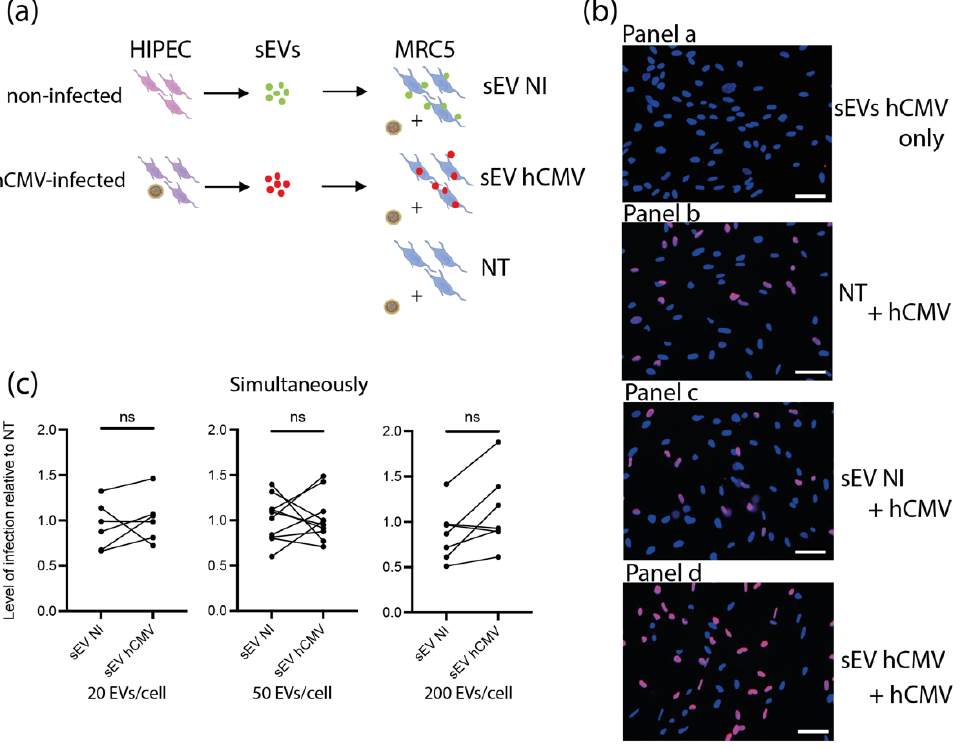
Figure 4. Effect of HIPEC sEVs on MRC5 cell permissiveness for hCMV. ( a ) Experimental procedure (NT = non-treated). ( b ) Immunofluorescence performed on MRC5 cells against IE viral antigen (blue: DAPI; red: IE1/2). Panel a- Non-infected control MRC5 cells upon 24 h incubation with sEVs isolated from hCMV-infected HIPECs. Panels b,c,d- MRC5 cells were either non-treated (Panel b- NT) or incubated during 2 h with sEVs prepared from non-infected (Panel c- sEV NI) or infected HIPECs (Panel d- sEV hCMV) with 50 sEV per cell, then infected during 24 h with hCMV at a MOI of 0.5 before proceeding to immunofluorescence. Scale bar: 200 μ m. ( c , d ) MRC5 cells were incubated with sEVs prepared from non-infected (sEV NI) or hCMV-infected (sEV hCMV) HIPECs and infected by hCMV at a MOI of 0.5, concomitantly ( c ) or 2 h after sEV incubation ( d ). Three increasing doses of sEVs were used in these experiments (20, 50, or 200 sEV per MRC5 cell, from left to right). Then, 24 h later, expression of IE antigen was assessed by immunofluorescence. Quantification of the percentage of IE positive cells was carried out and normalized by the percentage of cells infected by hCMV without any sEV (NT). Each dot is an independent experiment and corresponds to the mean of the counting of 10 fields, with around 70 cells counted, i.e., around 700 cells per dot. n = 4 to 10 independent experiments. Since sEVs used in infection assays were prepared each time in parallel between non-infected and hCMV-infected HIPECs from a given batch, statistical analysis was done by pairing the results between sEV NI and sEV hCMV for each